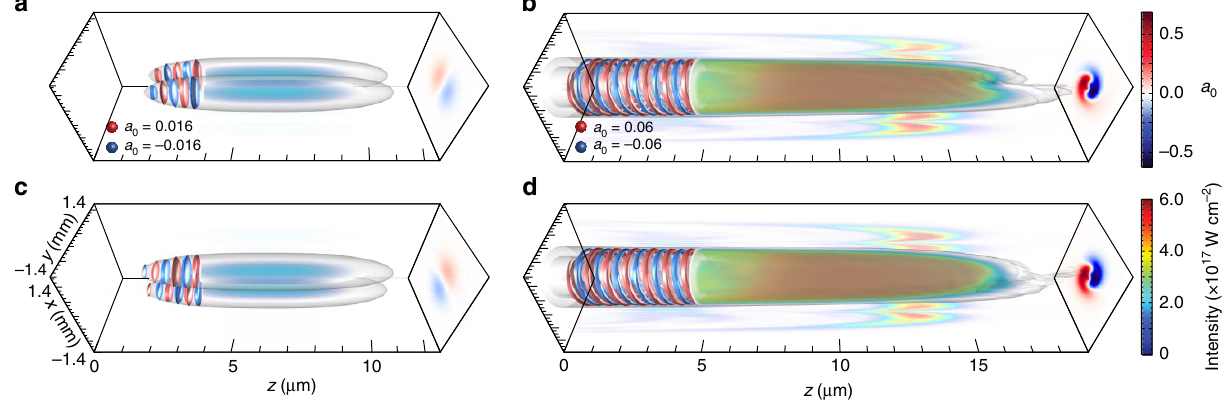
Figure 4 | Simulation result showing the generation and amplification of a new OAM mode from initial configurations with no net OAM. The new mode is linearly polarized in x and in y with ‘ 1 x ¼ ‘ 1 y ¼ (cid:2) 1 from an initial seed polarized in the x direction with a TEM 01 mode and in the y direction with a TEM 10 mode that is p /2 out of phase with respect to the TEM 01 mode polarized in x . The pump is a Gaussian laser linearly polarized at 45 (cid:2) . The initial laser set-up corresponds to Fig. 1c. The meaning of the colour scales and physical quantities plotted in all panels are identical to Fig. 3. The values of the laser vector potential illustrated by the isosurfaces of a , c are shown by the spheres in a . Those iso-surface values for b , d are indicated in b . ( a , c ) The initial seed TEM modes in x - and y directions, respectively. ( b , d ) The new OAM mode electric field components at z ¼ 3.5mm in x ( b ) and y ( d ). NATURE COMMUNICATIONS|7:10371|DOI: